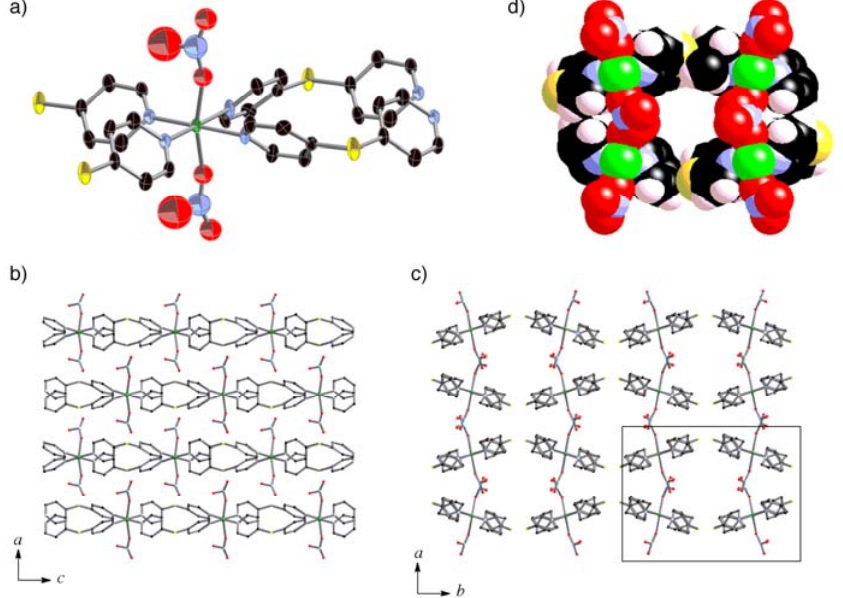
Figure S4. Crystal structure of 5 . The coordination circumstance ( a ) and stacking pattern in the ac plane ( b ) and ab plane ( c ). The channel structure with van der Waals radii is shown ( d